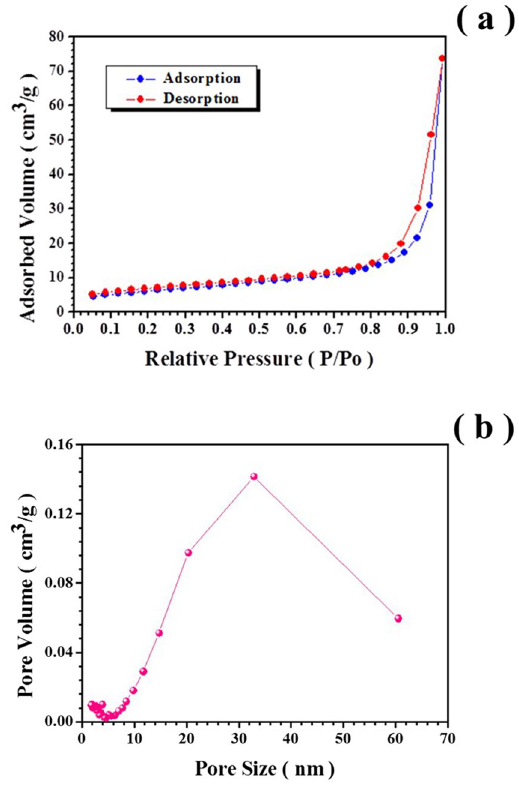
Figure 4. ( a ) Nitrogen adsorption-desorption isotherm curve of Sample E. ( b ) Pore size distribution curve of Sample